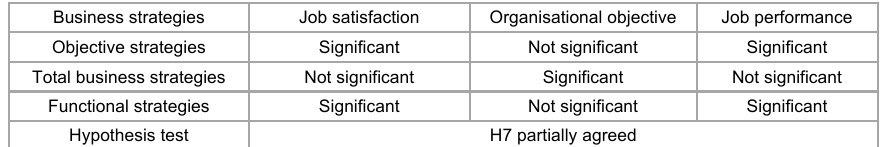
Effects of culture for innovation at all levels on the relations between business strategies and organisational